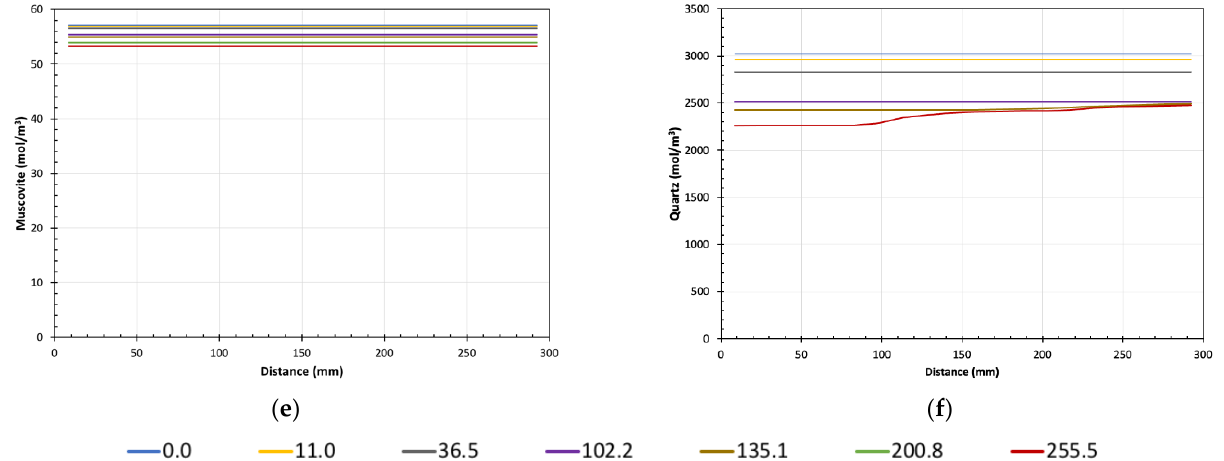
Figure 11. Legend for all plots; time step (days), selected model data showing variation along the length of the column with time; ( a ) porosity, red dashed line indicates initial porosity; ( b ) total C-S-H; ( c ) total zeolites; ( d ) albite (as a representative of the feldspars); ( e ) muscovite; ( f ) quartz. Time step of 102 d, change from ‘young’ to ‘evolved’ OPC leachate; time step of 200 d, change from ‘evolved’ OPC leachate to MGW.